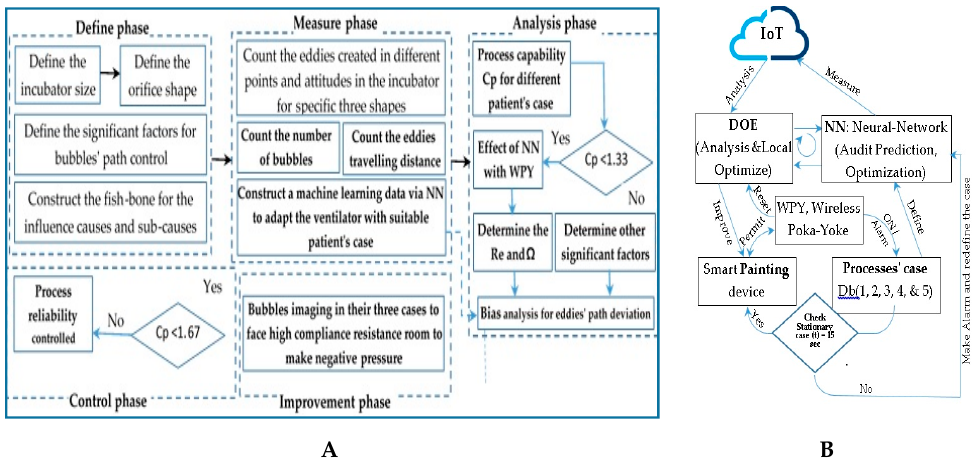
Figure 1. Problem-tackling Phases. Figure 1. ( A ) The tackling validation cycle via DMAIC; ( B ) The IoT relation with optimization tools via